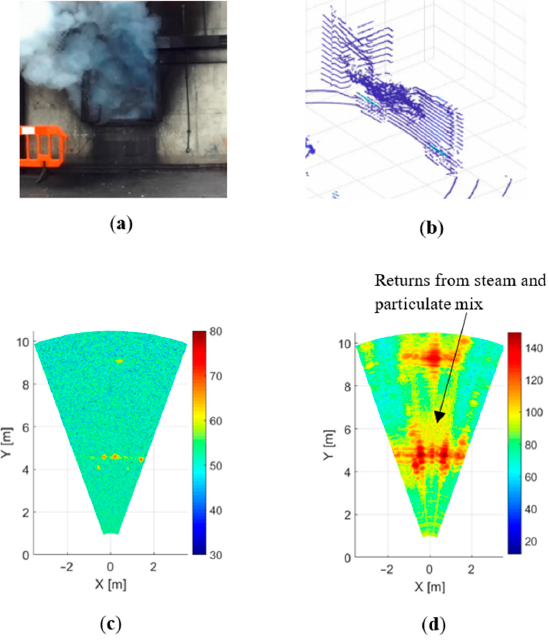
Figure 6. Steam and particulate mix environment: ( a ) camera, ( b ) LIDAR, ( c ) 300 GHz radar and ( d ) 79 GHz radar. ( d ) 79 GHz